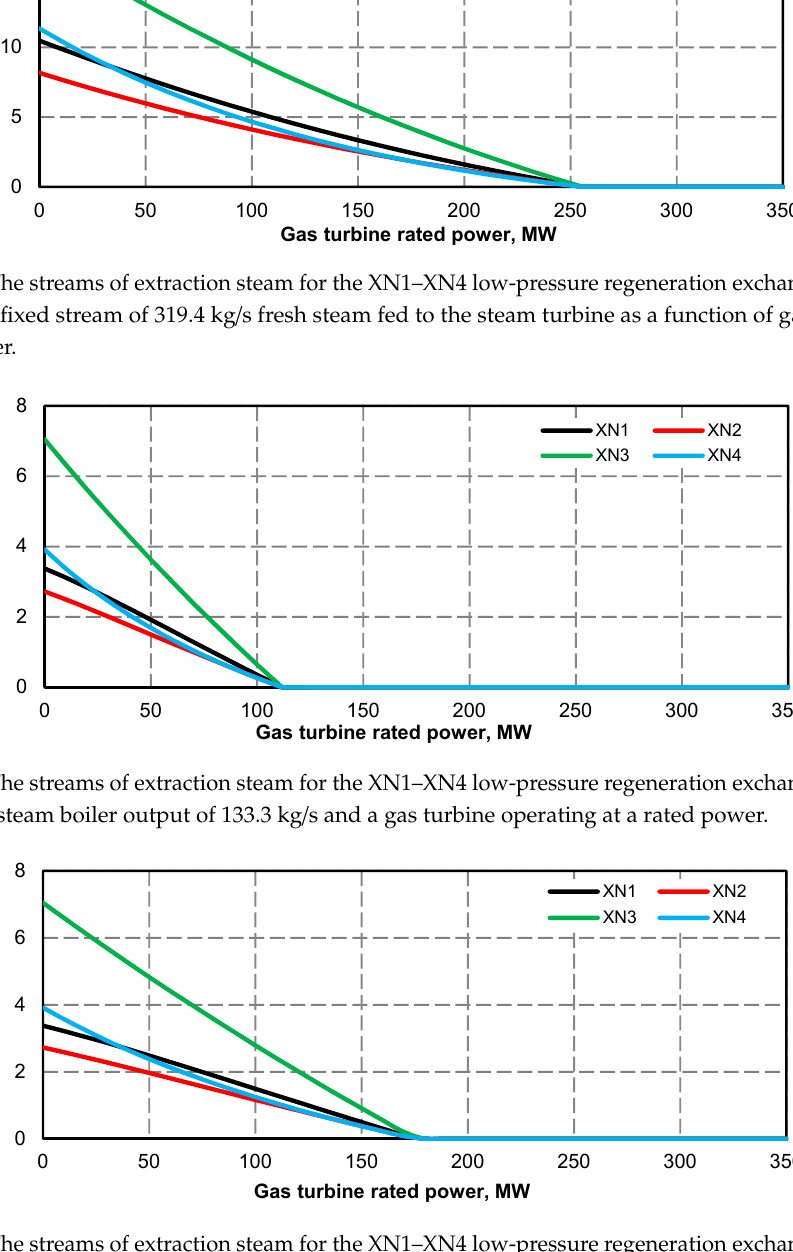
Figure 8. The streams of extraction steam for the XN1–XN4 low-pressure regeneration exchangers for a minimum steam boiler output of 133.3 kg/s and gas turbine operating at 60% of its rated power.